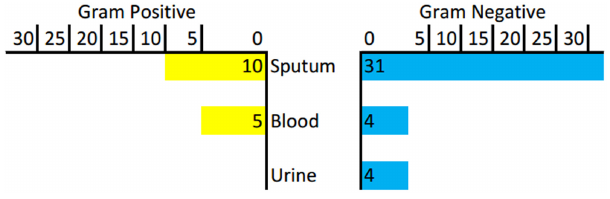
Figure 2. Distribution of Gram-positive and Gram-negative